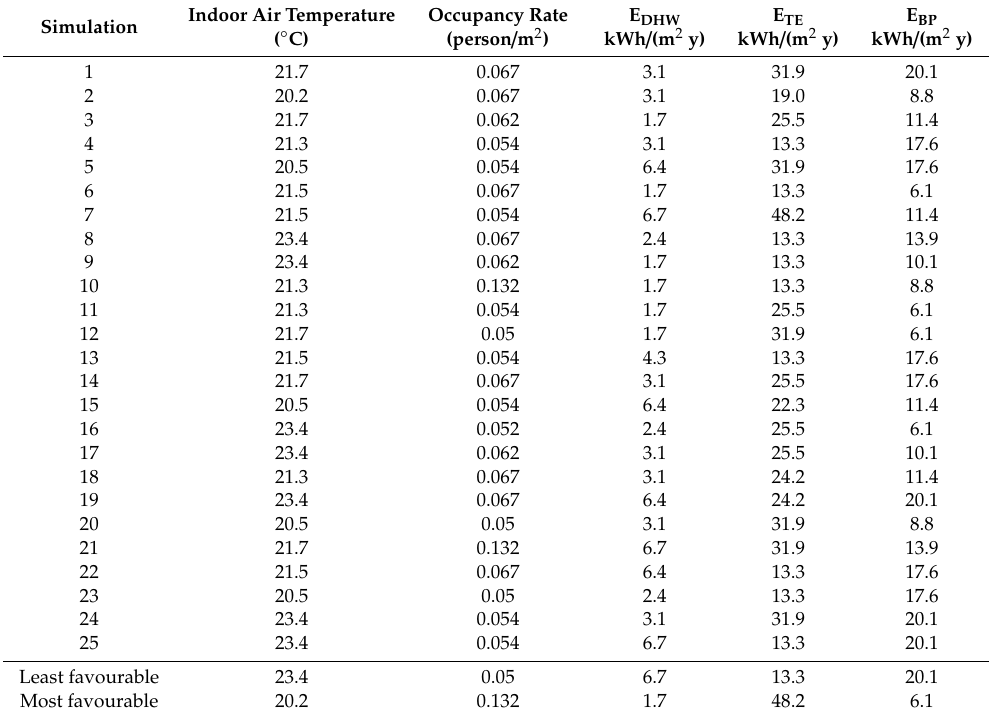
Table 3. The 25 sets of combinations of user-related input data, and the least and most favourable combinations for low-energy